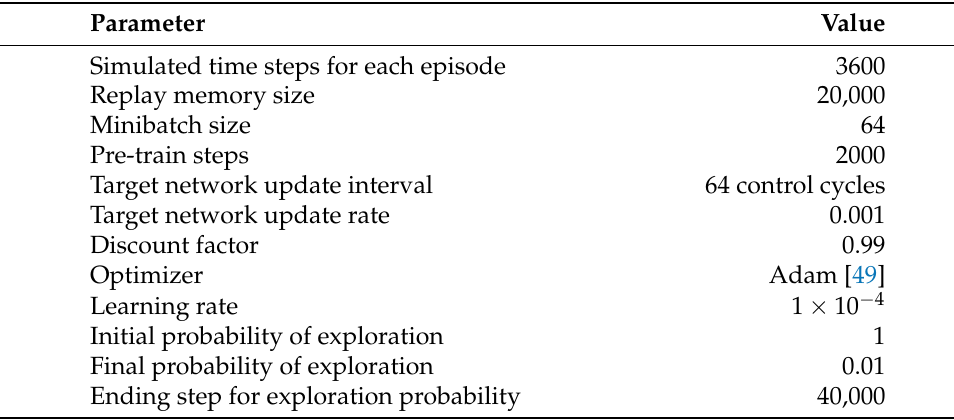
Table 2. Hyper-parameters of deep reinforcement learning